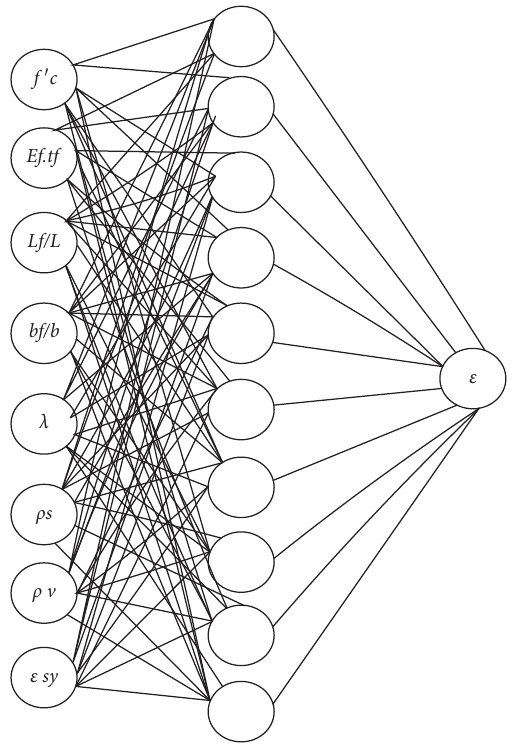
Figure 4: Topology of